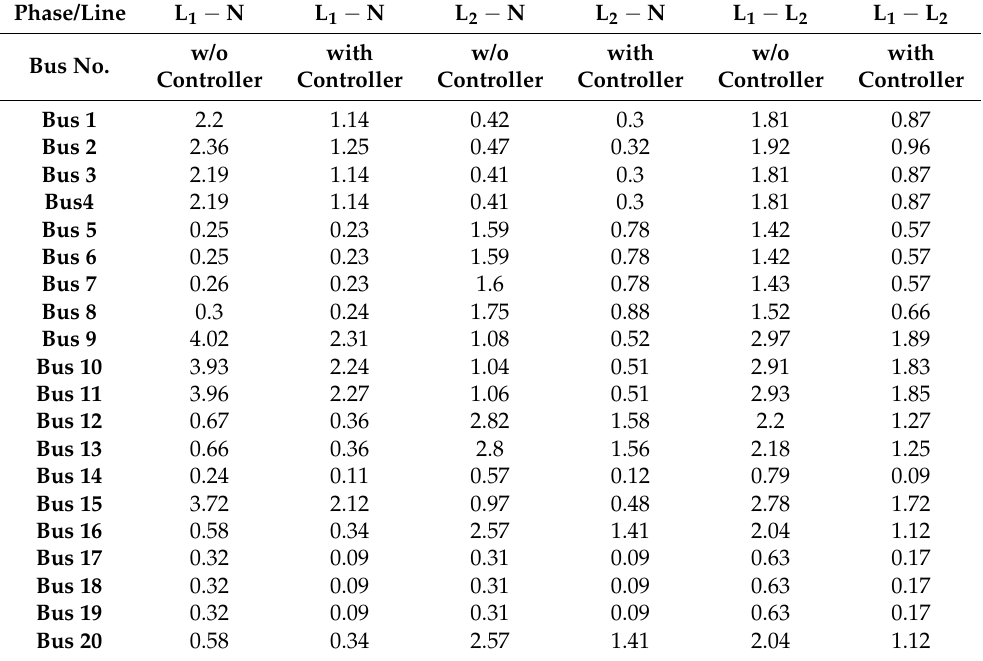
Table 9. Root mean square deviation in voltages in scenario 4 with and without the proposed